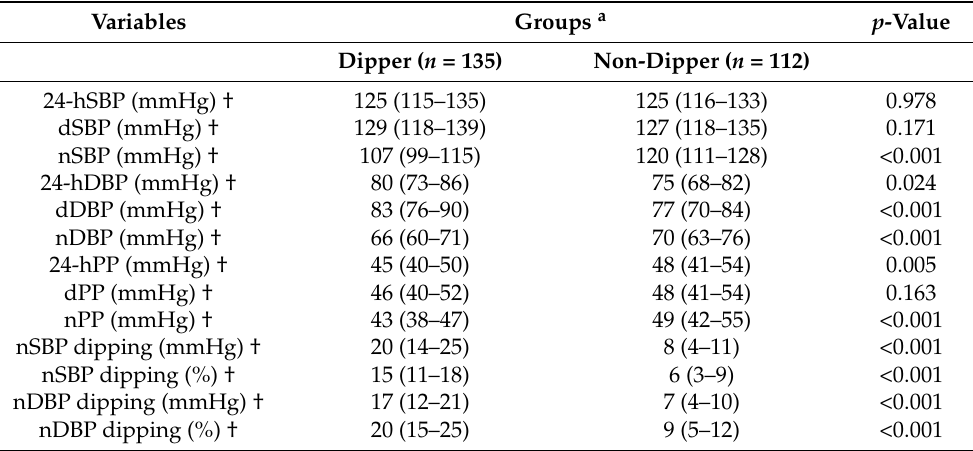
Table 2. Twenty-four-hour ambulatory blood pressure monitoring. Comparison of blood pressure indices between dipper and non-dipper